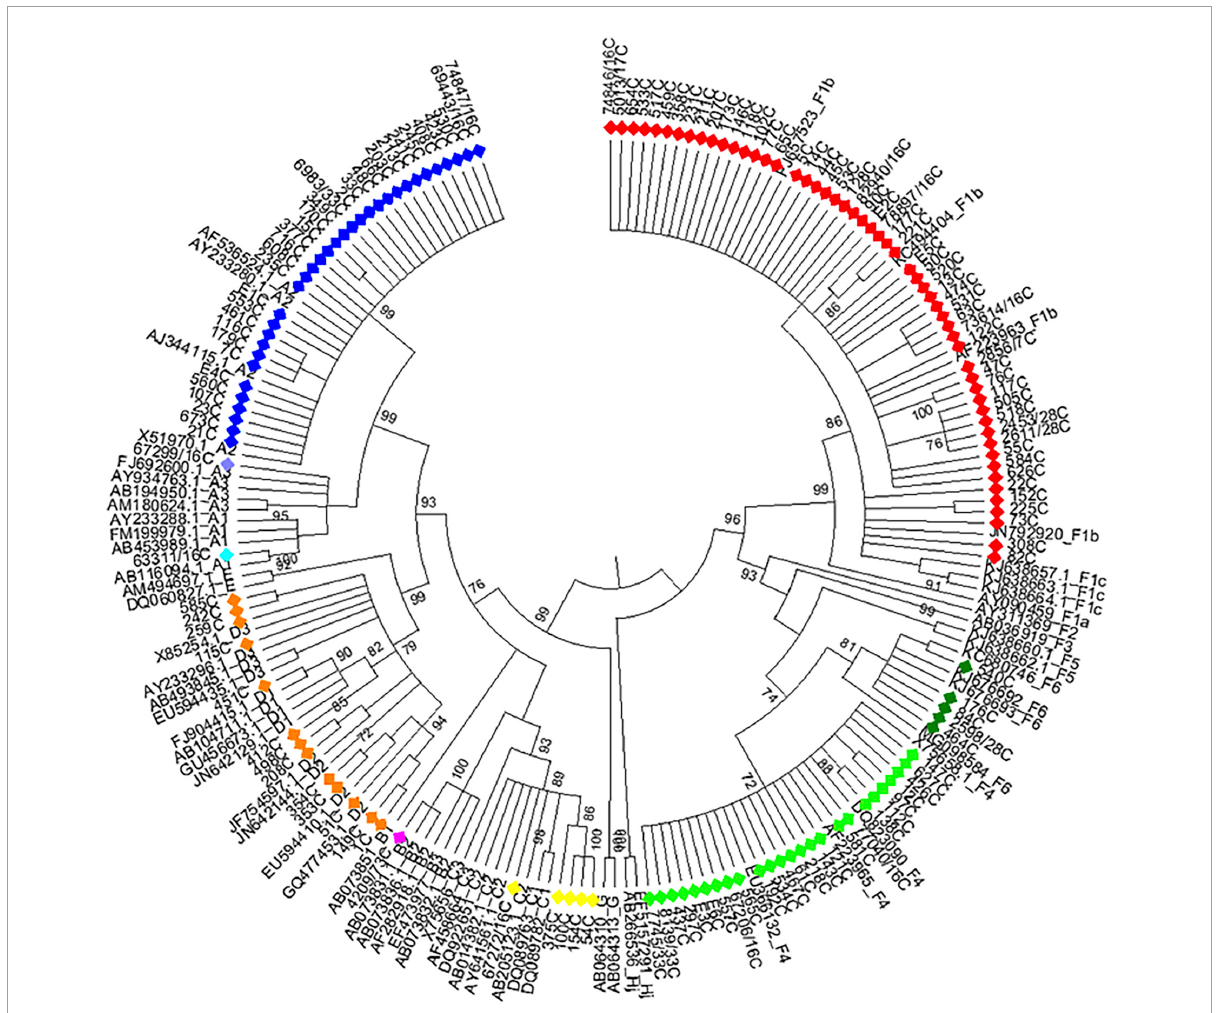
FIGURE2 Maximum likelihood phylogeny of chronic hepatitis B samples from Córdoba, Argentina. Maximum likelihood phylogenetic tree obtained using sequences of 1,169 nucleotides, resulting from concatenated sequences of the S (471 nucleotides) and BCP-pC genomic regions (698 nucleotides) of chronic hepatitis B samples from central Argentina and reference sequences from each genotype or subgenotype available at GenBank. The phylogenetic tree was constructed with MEGA v.6 (bootstrap: 1000 replicates). References: A1, light blue; A2, blue; A3, lavender; B, fuchsia; C, yellow; D, orange; F1b, red; F4, light green; F6,